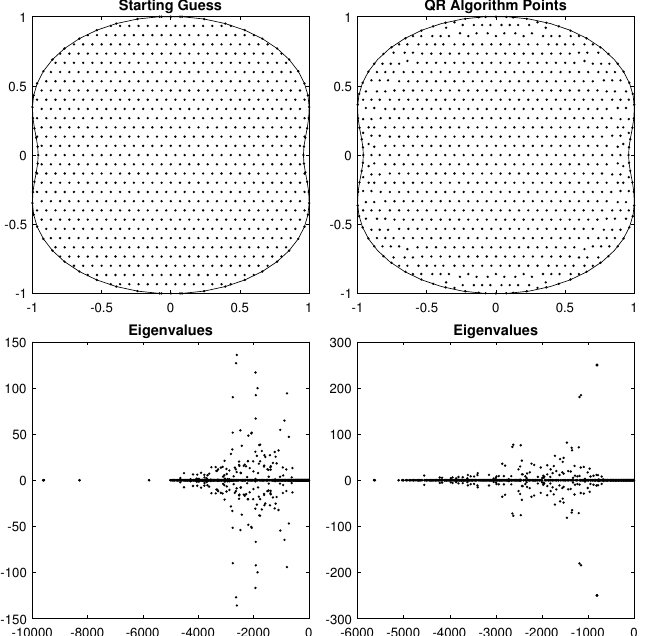
Figure 16. Hexagonal points and resulting MCpQR algorithm points with Dirichlet Laplacian eigenvalues for the peanut